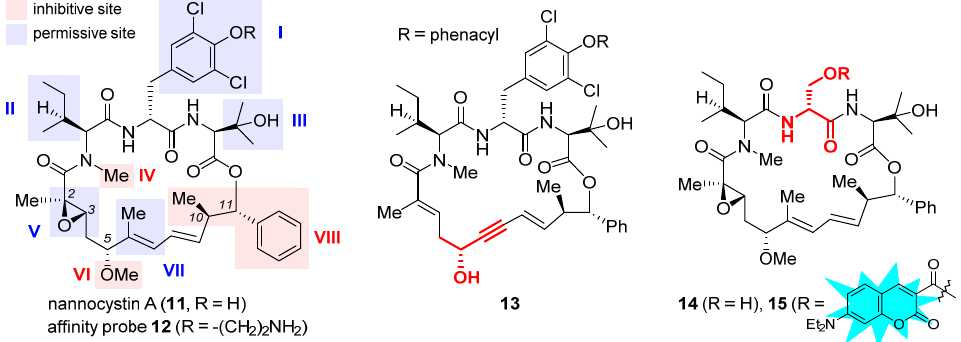
Figure 4. Structures of naturally occurring nannocystin A ( 11 ), semisynthetic affinity probe 12 , as well as synthetic macrocyclic propargylic alcohol 13 , serine-containing intermediate 14 , and coumarin-tagged fluorescent probe 15 . The SAR illustrated in the structure of 11 consists of inhibitive (red) and permissive (blue) sites: the former must be reserved for high activity, whereas the latter can tolerate moderate change.